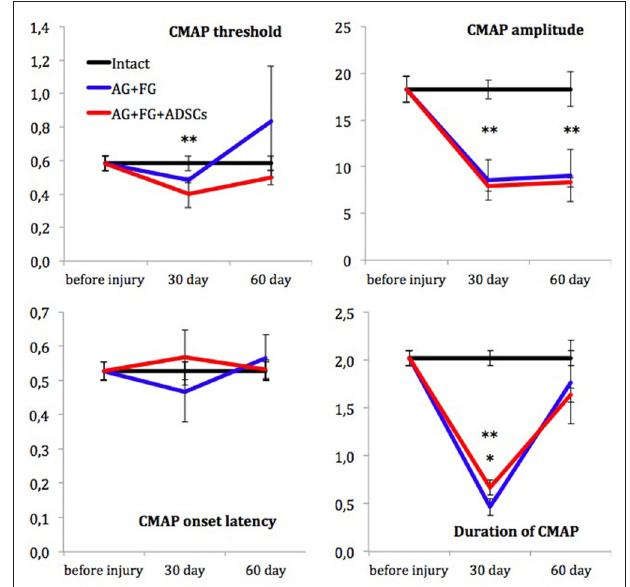
FIGURE 3 | Confocal miscopy images of longitudinal sections of the rat sciatic nerve after 7 (A,C) and 14 (B) days in the AG + FG + ADSCs group and 14 days in the AG group (D) . (A,B) The area of anastomosis of sciatic nerve after 7 days (A) and 14 days (B) the penetration of ADSCs-eGFP through the suturing area is shown. (C) The inability of ADSCs-eGFP invasion through the intact epineurium is shown. (D) Absence of fluorescence in the AG-group is shown. #, the needle hole; a dotted line, nerve anastomosis. The green fluorescence indicates transplanted cells expressing e-GFP; blue fluorescence indicates cell nuclei stained with DAPI. Scale bars: 100 µ m.